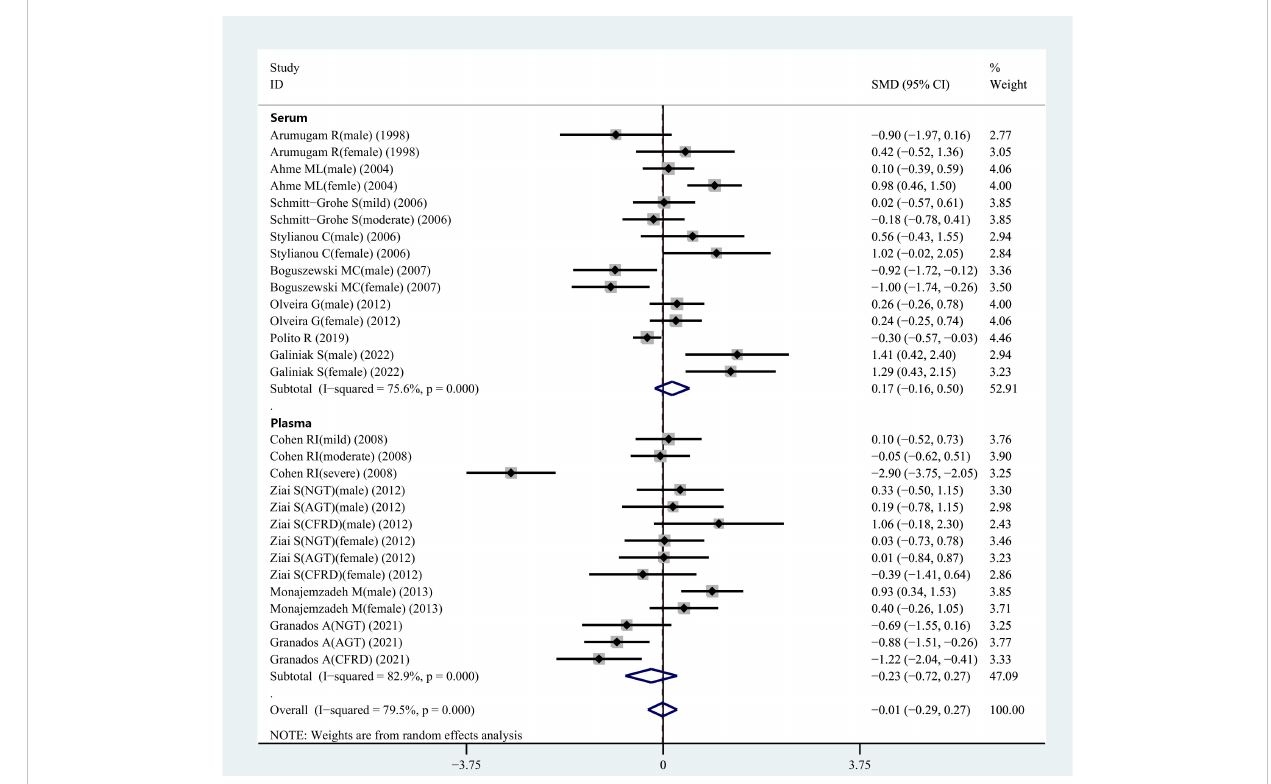
FIGURE 2 SMD forest plot and its 95%CI for serum/plasma leptin concentrations in the CF group and the control